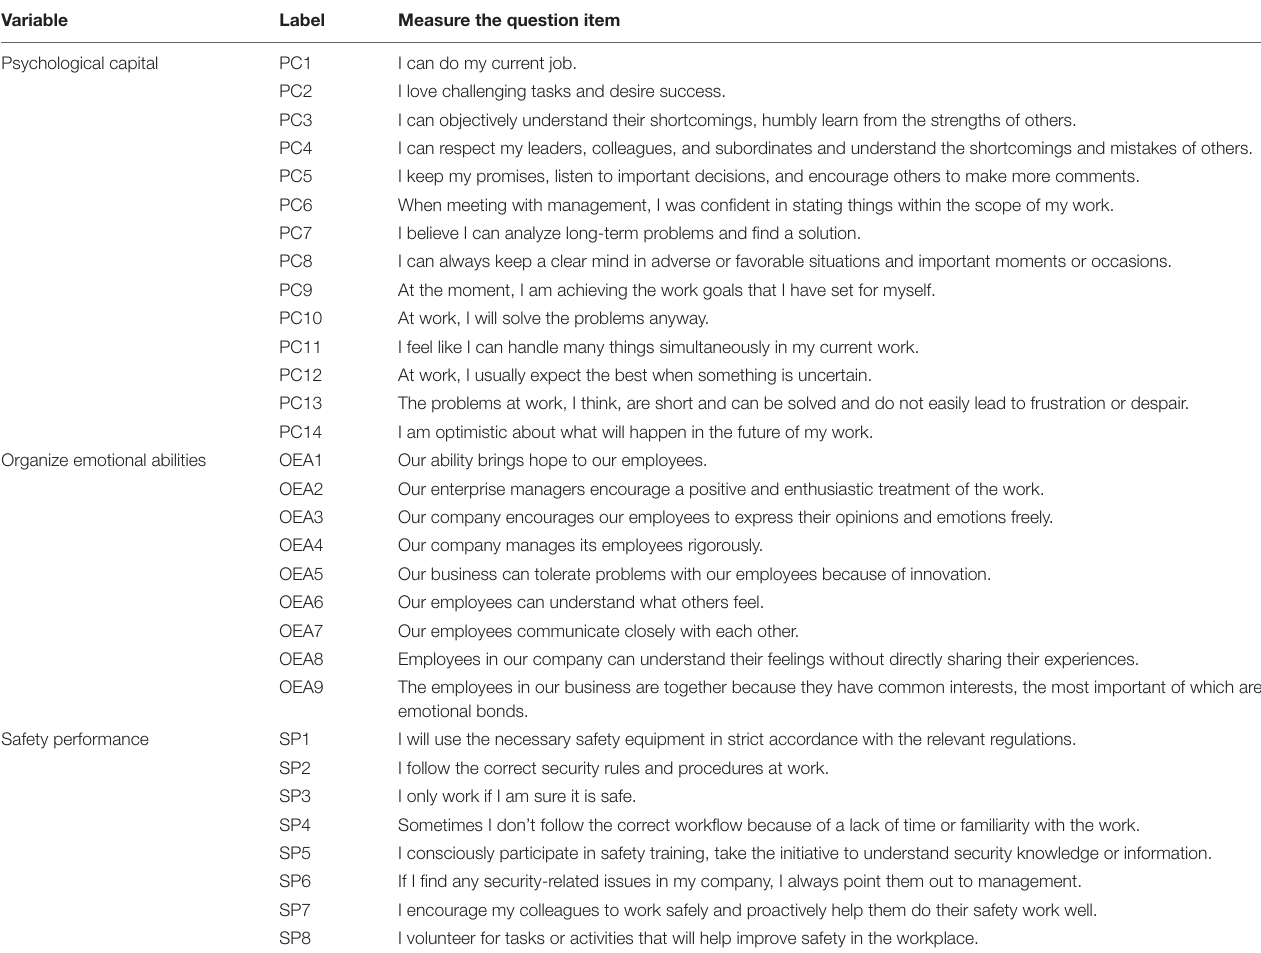
TABLE 2 | Variable measurement items. Variable Label Measure the question